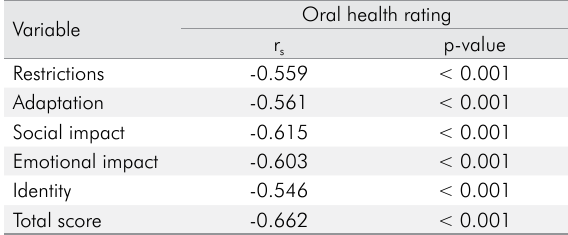
Table 6. Factor loadings of the confirmatory factor analysis. Standardized